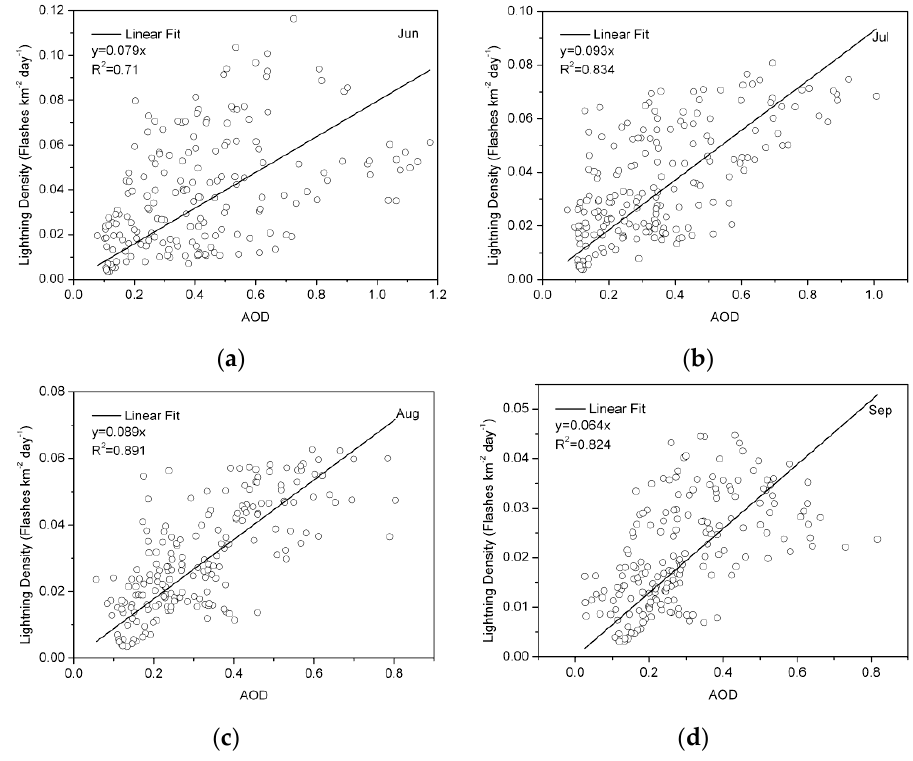
Figure 6. Correlation between lightning flash density (flashes km − 2 ·year − 1 ) and AOD for June to September over China. ( a ) June; ( b ) July; ( c ) August; ( d ) September.